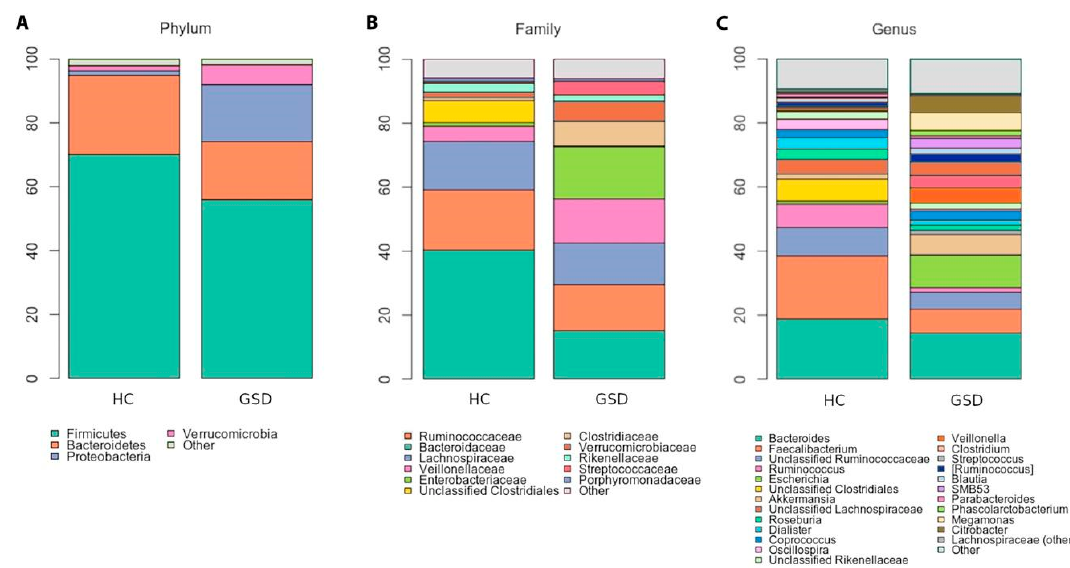
Figure 2. Taxonomic characterization. Stacked bar charts of taxonomy relative abundances at ( A ) phylum, ( B ) family and ( C ) genus levels for healthy controls (HC) and GSD patients. Only phyla, families and genera present at relative abundances > 1% in at least 20% subjects (i.e.,: ≥ 4 samples) are reported. Remaining taxa are grouped in the “Other” category for each level.